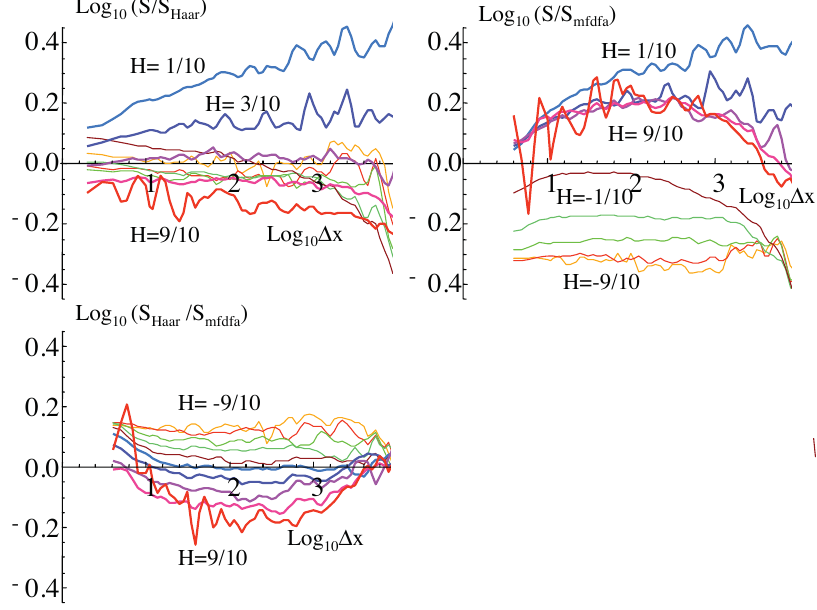
D E 1 / 2 1v 2 ) for the simulations discussed in the text. Upper Fig. 9. These graphs compare the ratios of RMS structure functions ( S (1x) = left shows the ratio of the RMS usual structure function (i.e. difference when H > 0, tendency when H < 0) to the Haar structure function for H = 1 / 10 , 3 / 10 ,.. 9 / 10 (thick, top to bottom), and − 9 / 10, − 7 / 10 ,... − 1 / 10, (thin, top to bottom). The Haar structure function has been multiplied by 2 ξ( 2 )/ 2 to account for the difference in effective resolution. The central flat regions where the scaling is accurate indicate a = S/S Haar which is typically less than a factor of two. Upper right is the same but for the ratio of the usual to MFDFA constant ratio C 0 Haar RMS structure functions after the MFDFA was normalized by a factor of 16 and the resolution correction 4 ξ( 2 )/ 2 (its smallest scale is 4 pixels). Bottom left shows the ratio of the MFDFA structure function to the Haar structure function both with the normalization and resolution corrections indicated above (note the monotonic ordering with respect to H , which increases from top to